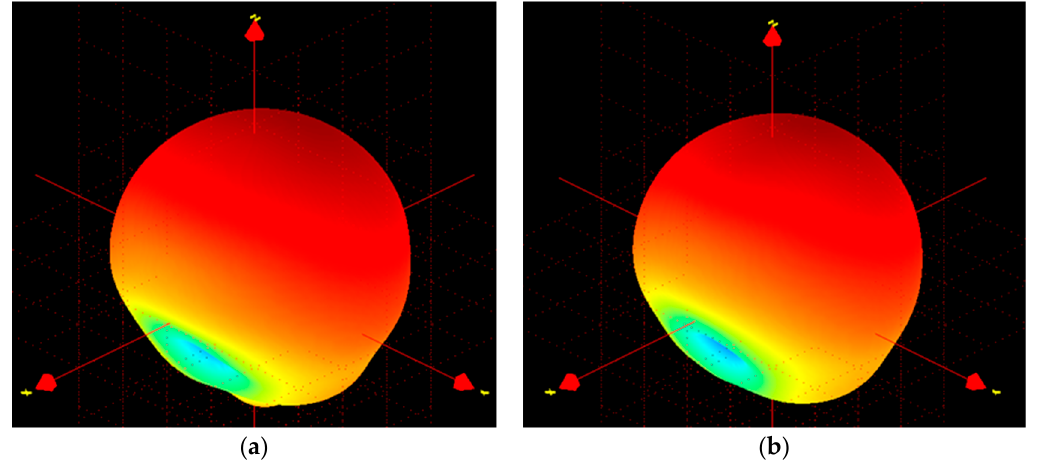
Figure 7. Measured 3D radiation pattern at ( a ) 1.63 GHz and ( b ) 1.68 GHz.